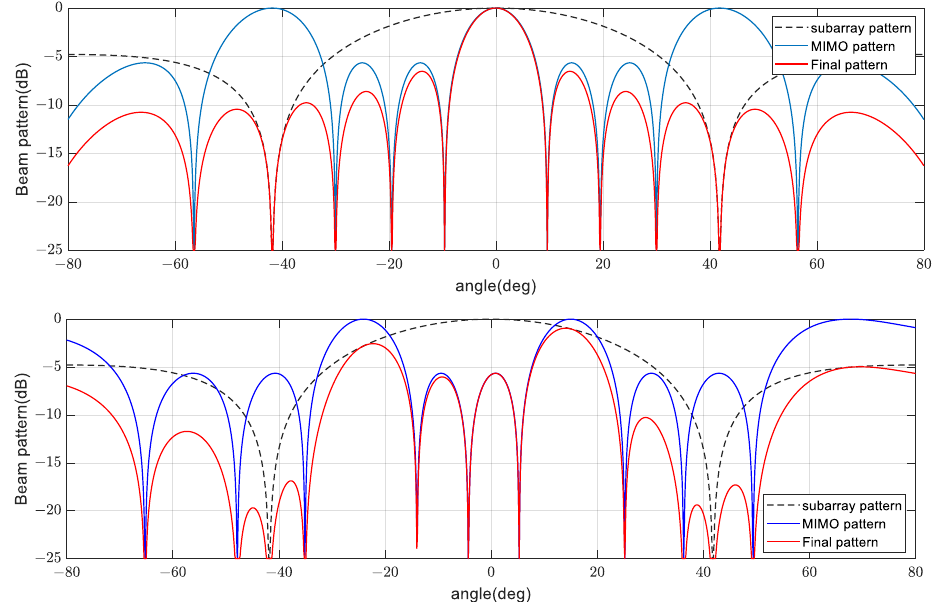
Figure 8. The final beampattern with RX subarrays in the case of steering to 0° ( upper ) and 15° ( lower ).